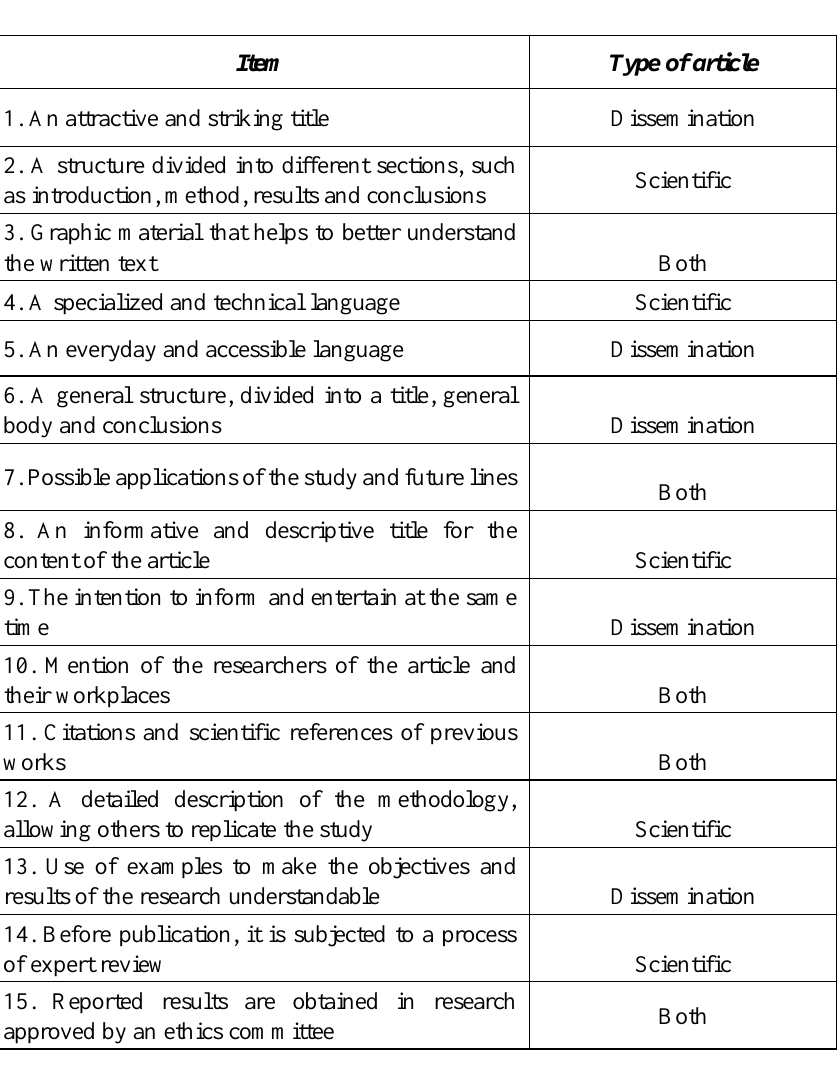
Items of the Questionnaire on knowledge of scientific and dissemination